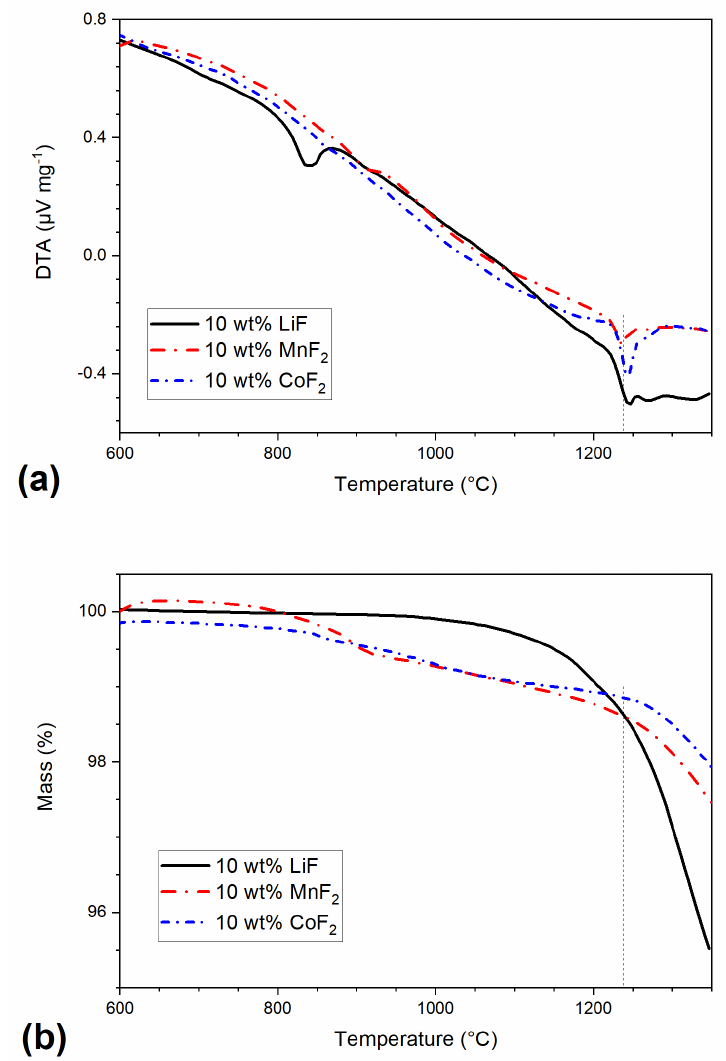
Figure 3. DTA ( a ) and TG ( b ) records of samples comprising 10 wt% of LiF, MnF 2 , and CoF 2 , heating rate = 20 °C min − 1 . Vertical line at 1230 °C represents onset of melting for TM fluorides doped spinel ceramics.